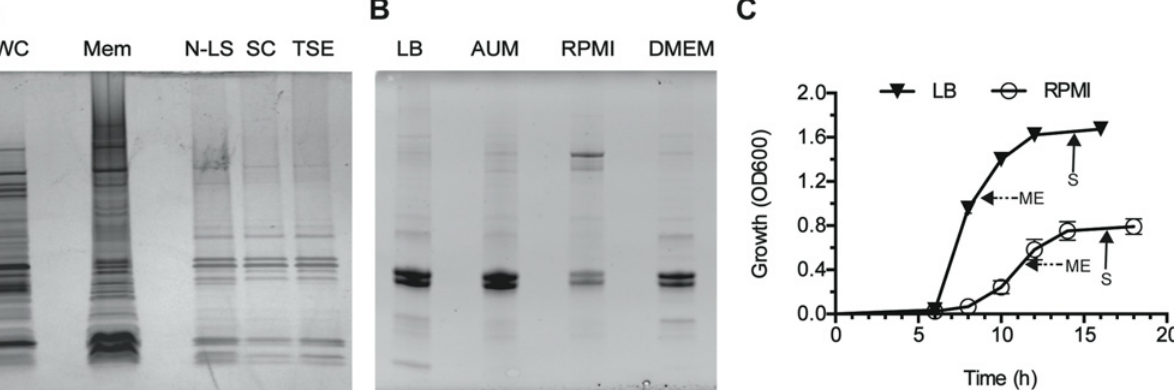
Fig 2. Enrichment of K . pneumoniae outer membrane proteins. (A) Protein profile at each step in the outer membrane (OM) extraction process. WC = whole cell lysate from K . pneumoniae isolate 30660, Mem = total membrane fraction, N-LS = N-lauroylsarcosine treatment, SC = sodium carbonate wash, TSE = Tris-sucrose-EDTA. (B) Comparison of outer membrane proteins in different media. AUM = artificial urine media. (C) Growth of K . pneumoniae isolate 30660 in LB or RPMI. Arrows with solid lines indicate sample collection at mid-exponential (ME) phase of growth and arrows with dashed lines indicate sample collection at stationary (S) phase of